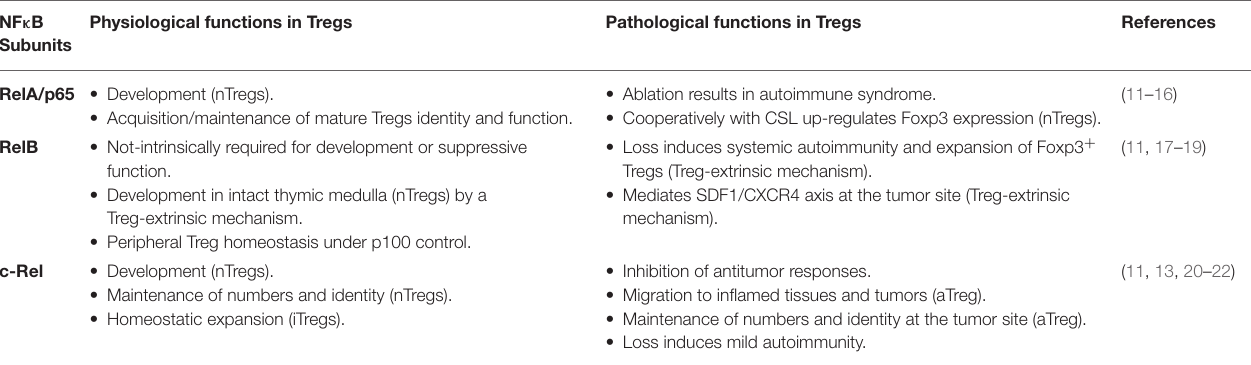
TABLE 1 | Function of distinct NF- κ B subunits in physiological T-reg activity and in cancer. NF κ B Physiological functions in Tregs Pathological functions in Subunits